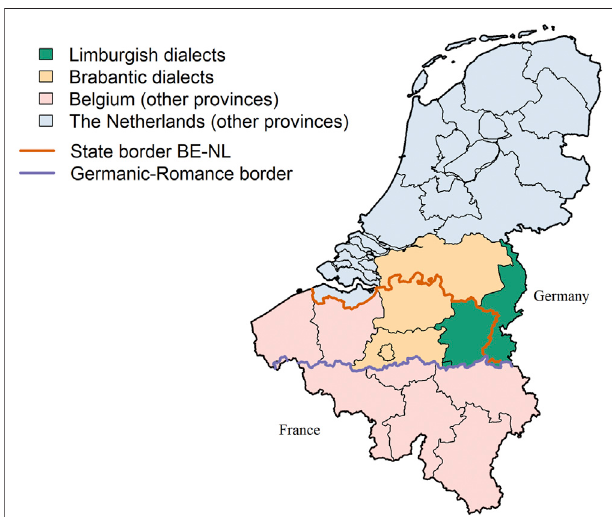
FIGURE 1 | The Limburgish dialect region (in green). The brown line withinthegreenareaistheboundarybetweentheDutch(onthe right )andthe Belgian (on the left ) province of Limburg. The purple line in the south of the dialect region shows the boundary between the Dutch-speaking (northern) and French-speaking (southern) part of Belgium. The other provinces of the Netherlands and Belgium are colored light-blue and pink.